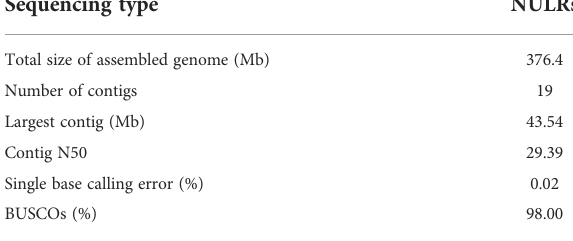
TABLE 1 The statistics of Nanopore ultra-long reads assembly results of